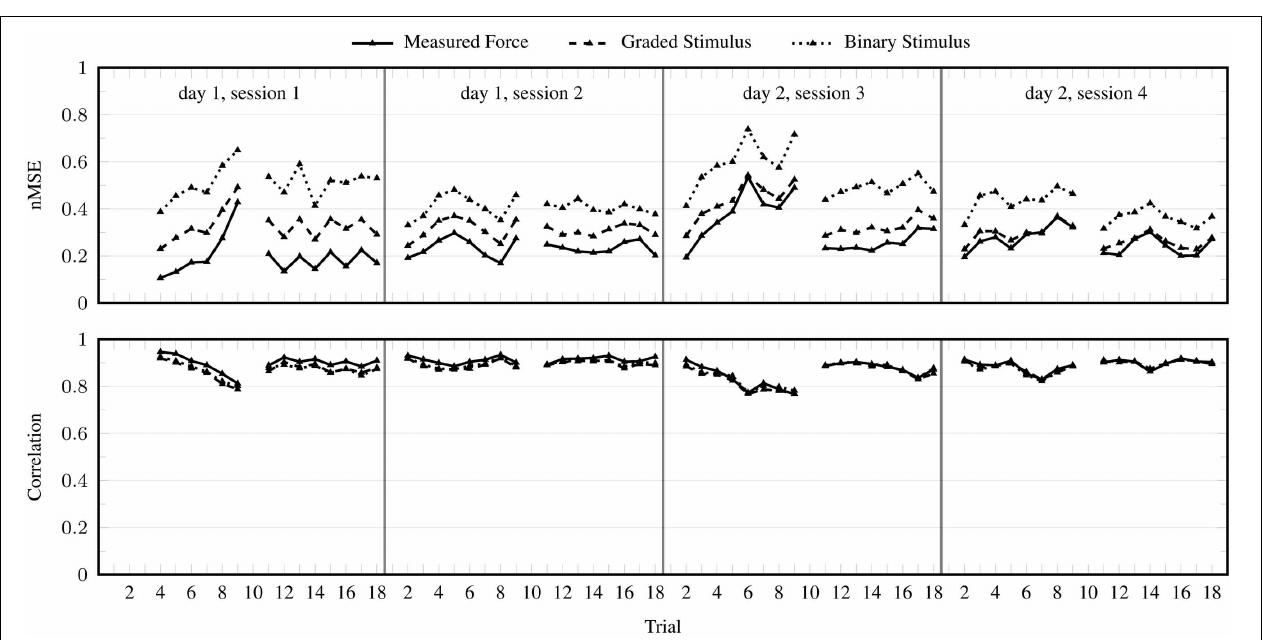
are averaged over the ten subjects and the five DOFs. For the iRFFRR method, the results are in addition averaged over 25 runs with different random initializations.